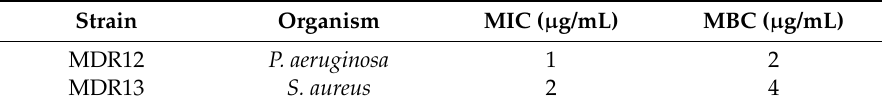
Table 2. MIC value of